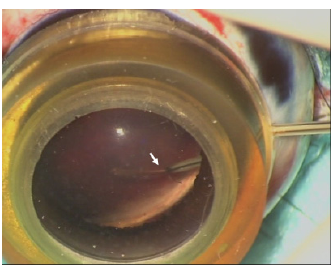
Figure 4. Intravitreal implantation of a dry PEA fibril in rabbits. Note that the fibril (arrow) is still in contact with the catheter protruding into the vitreous